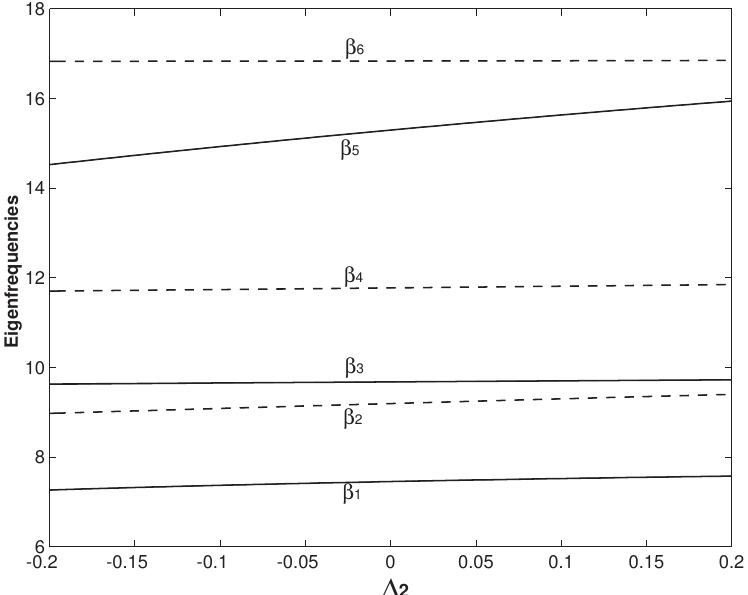
Figure 11. The first six eigenfrequencies as the functions of ∆ 2 with the overhang length being set as ξ 1 = ξ 2 =